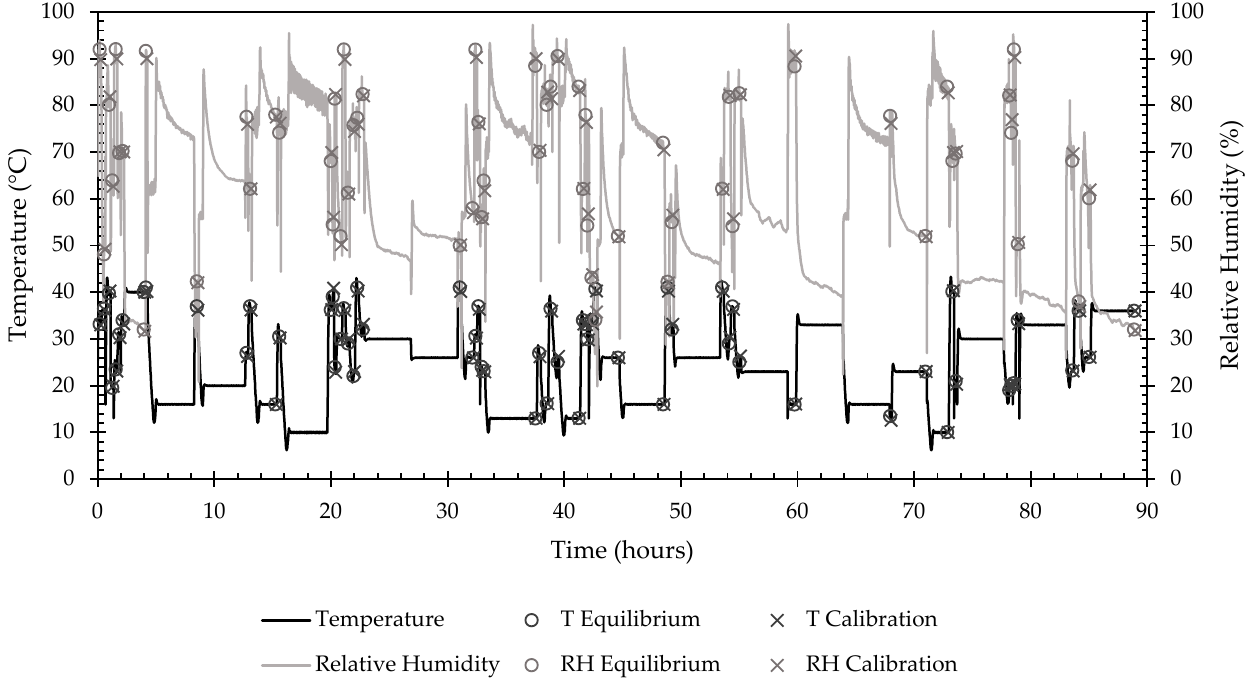
Figure 9. Time response of environmental chamber settings for temperature and relative humidity during a calibration run, with additional points of interest for the start of equilibrium threshold and calibration data collection periods. Lines show the temperature and relative humidity profiles over the duration of the calibration. O’s show when the chamber reached equilibrium and calibration data collection began. X’s show when calibration data collected ended.